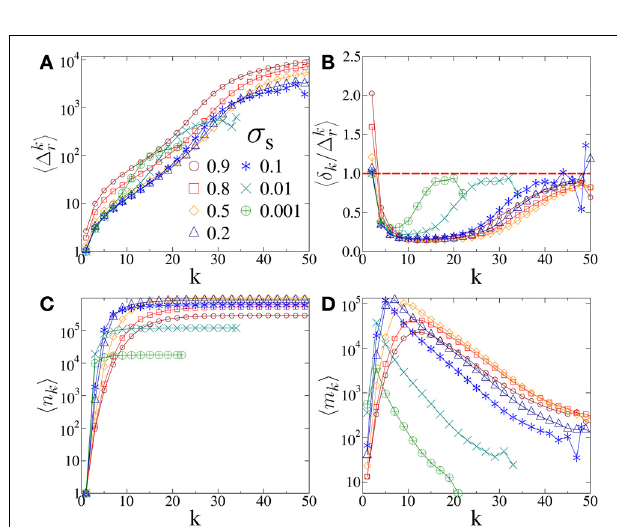
the external load σ s separately above and below σ ∗ s , respectively. The good quality data collapse demonstrates the validity of the scaling structure Equation (8).